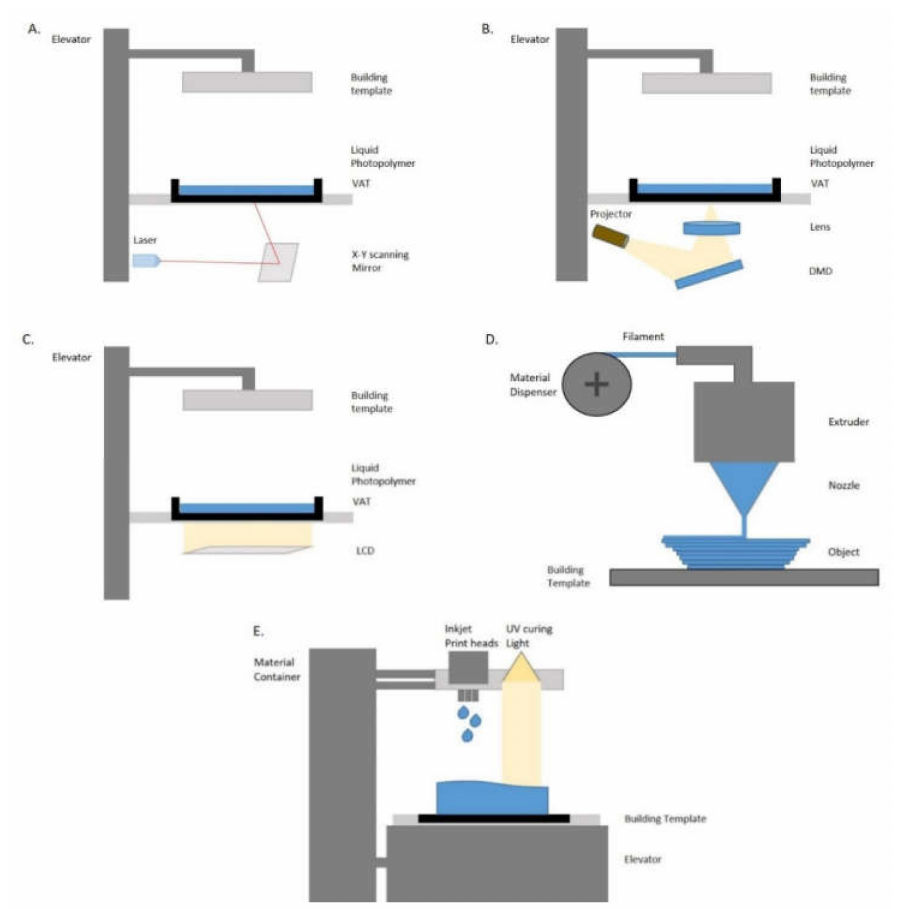
Figure 2. Three-dimensional printing technologies. ( A ) Laser-SLA, ( B ) DLP, ( C ) LCD, ( D ) FFF, and ( E )